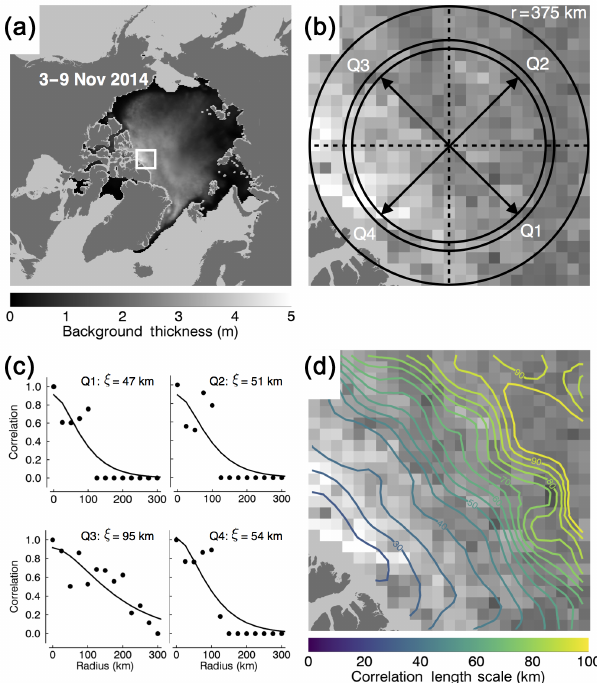
Figure 7. Scheme for the estimation of the correlation length scale ξ for a single grid cell for the target week 3–9 November 2014. (a) Background field with indicated area of interest (white box). (b) Adjacent ice thickness grid cells within a radius of 375km are binned into annuli of distance and four quadrants. (c) Binned thick- ness estimates are used to calculate the structure function of each quadrant. ξ is estimated by fitting an exponential function. (d) Con- tour map of estimated correlation length scales for the considered